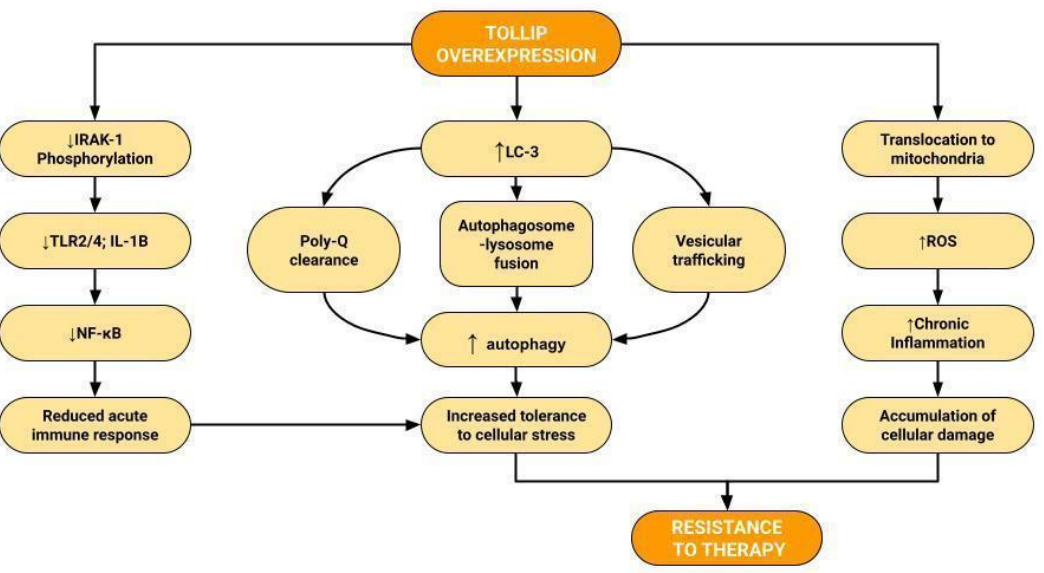
Figure 8. Effects of TOLLIP in renal cell carcinoma [8,43,49]. Overexpression of TOLLIP decreases IRAK-1 phosphorylation, reducing the activation of TLR2/4 and the secretion of IL-1B. It leads to decreased activity of NF-kB signaling and, in effect, reduced acute immune response. TOLLIP binds to LC-3, which stimulates autophagy by increased Poly-Q clearance, autophagosome–lysosome fusion, and vesicular trafficking. Augmented TOLLIP translocation to mitochondria increases ROS levels and sustains chronic inflammation. Reduced acute immune response and increased autophagy favor tolerance to cellular stress and the accumulation of cellular damage, which may cause resistance to therapy.